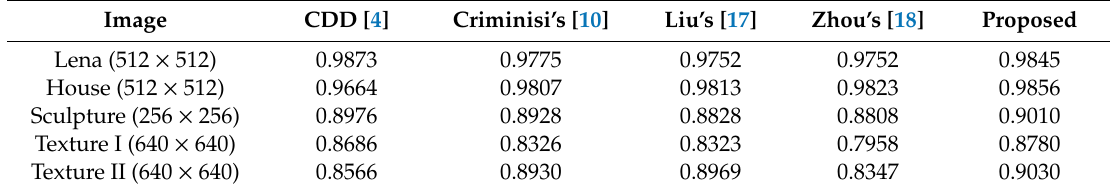
Table 2. Structural similarity index (SSIM) comparison of Figure 7, Figure 8, Figure 9, Figure 10 and Figure 11.